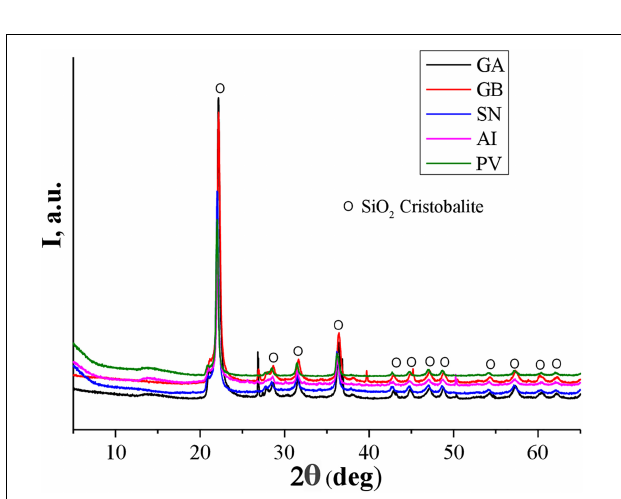
FIGURE 2 | XRD powder patterns of the biosilicas obtained from the tested marine sponges.